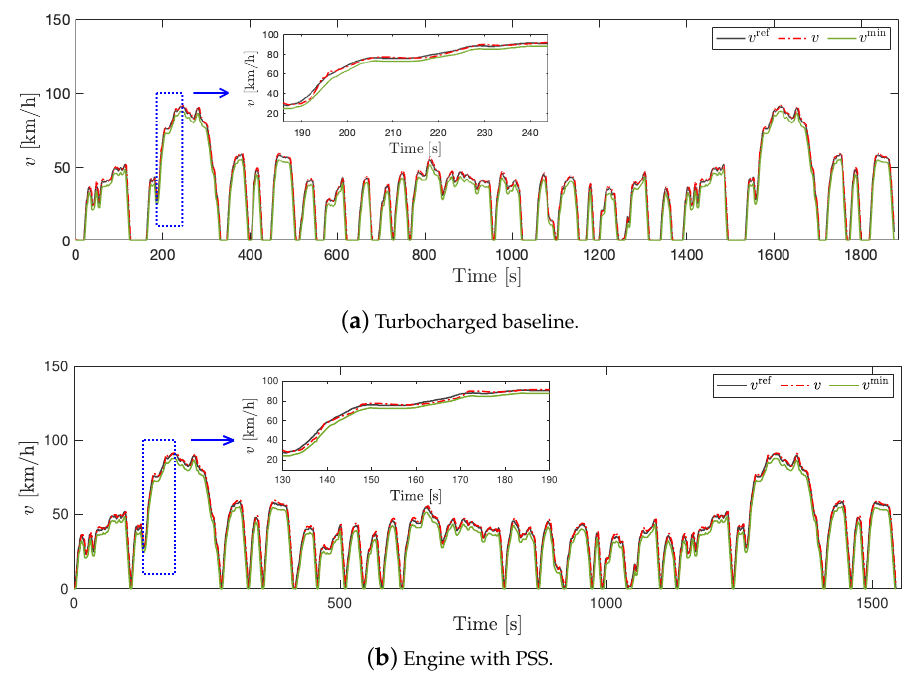
Figure 11. Velocity tracking during hardware-in-the-loop experiments, ( a ) vehicle with turbocharged engine, ( b ) vehicle with the PSS, stopped portions of the cycle removed to emulate